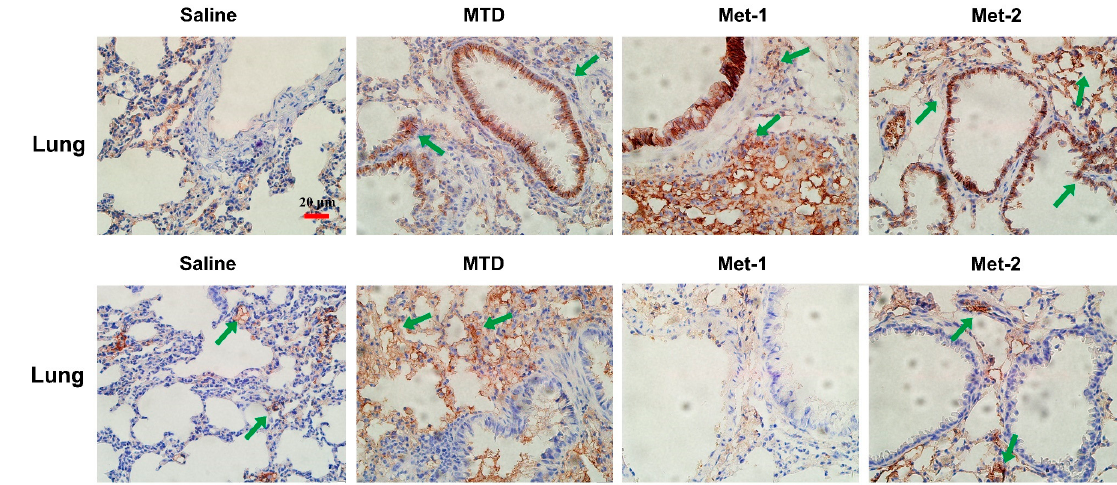
Figure 11. Immunohistochemistry of E-cadherin and N-cadherin in the lung(showed by green arrow). Immunohistochemistry of the lung for E-cadherin and N-cadherin markers of EMT was performed as previously described. Scale bar = 20 μ m.